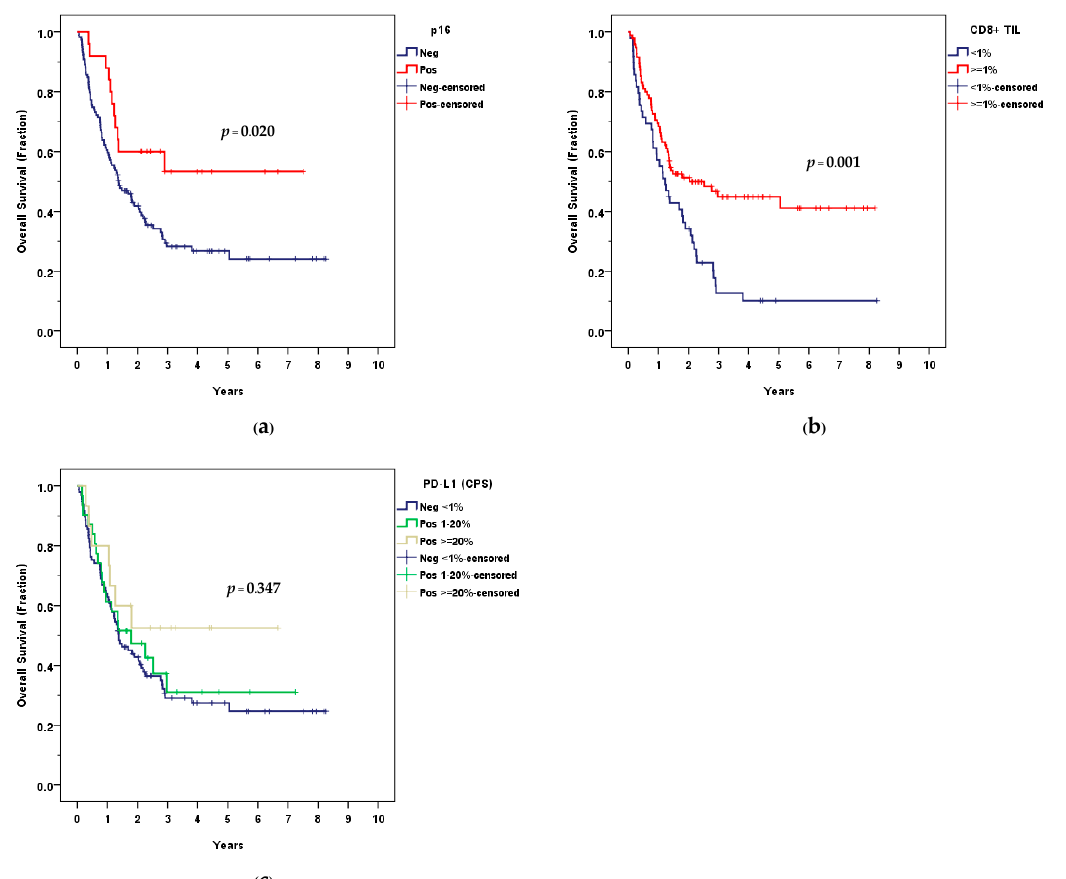
Figure A1 . Overall survival ( OS ) of a subgroup analysis without patients in stage I and patients with Figure A1. Overall survival (OS) of a subgroup analysis without patients in stage I and patients with distant metastases according to : ( a ) p16; ( b ) CD8 + TIL; ( c ) PD - L1 ( CPS ). distant metastases according to: ( a ) p16; ( b ) CD8+ TIL; ( c ) PD-L1